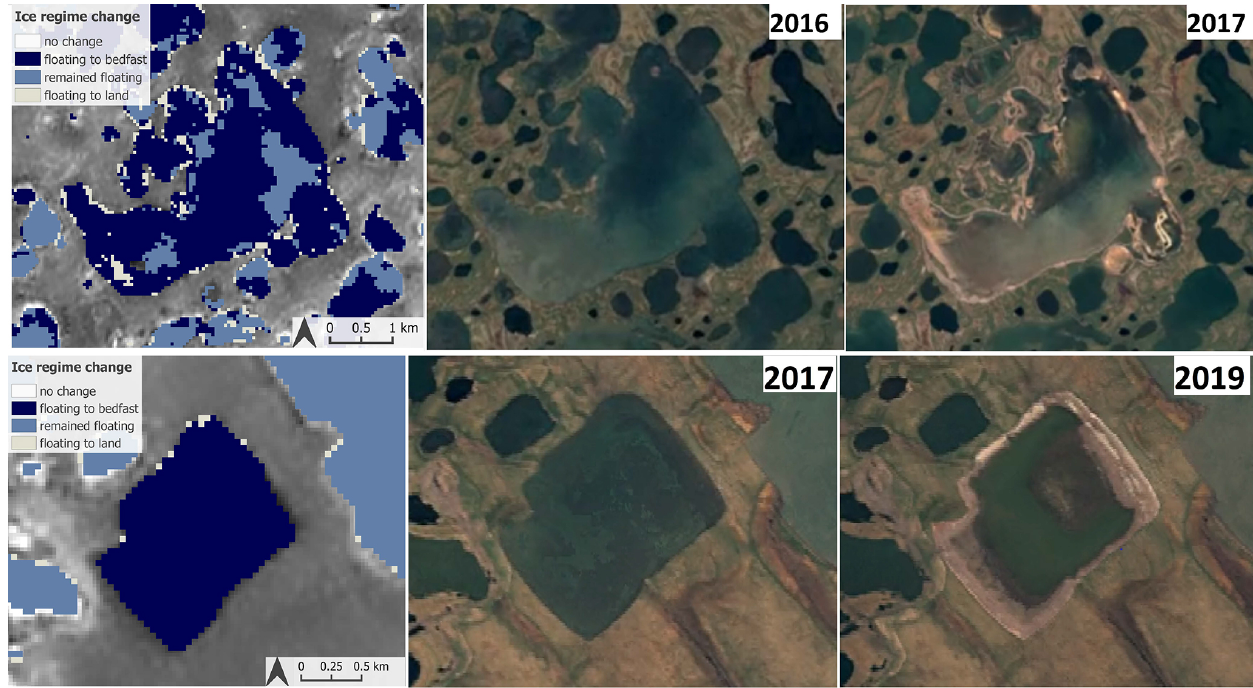
Figure 16. Lake no. 1 (top): transition from floating to bedfast-ice regime between 2010 and 2018 (left); water level changes visible on Landsat imagery between the summers of 2016 (center) and 2017 (right). Lake no. 2 (bottom): transition from floating to bedfast-ice regime between 2010 and 2018 (left); water level changes visible on Landsat imagery between the summers of 2017 (center) and 2019 (right). Landsat scenes were obtained from the Google Earth Timelapse tool (link: https://earthengine.google.com/timelapse/, last access: 15 Au- gust